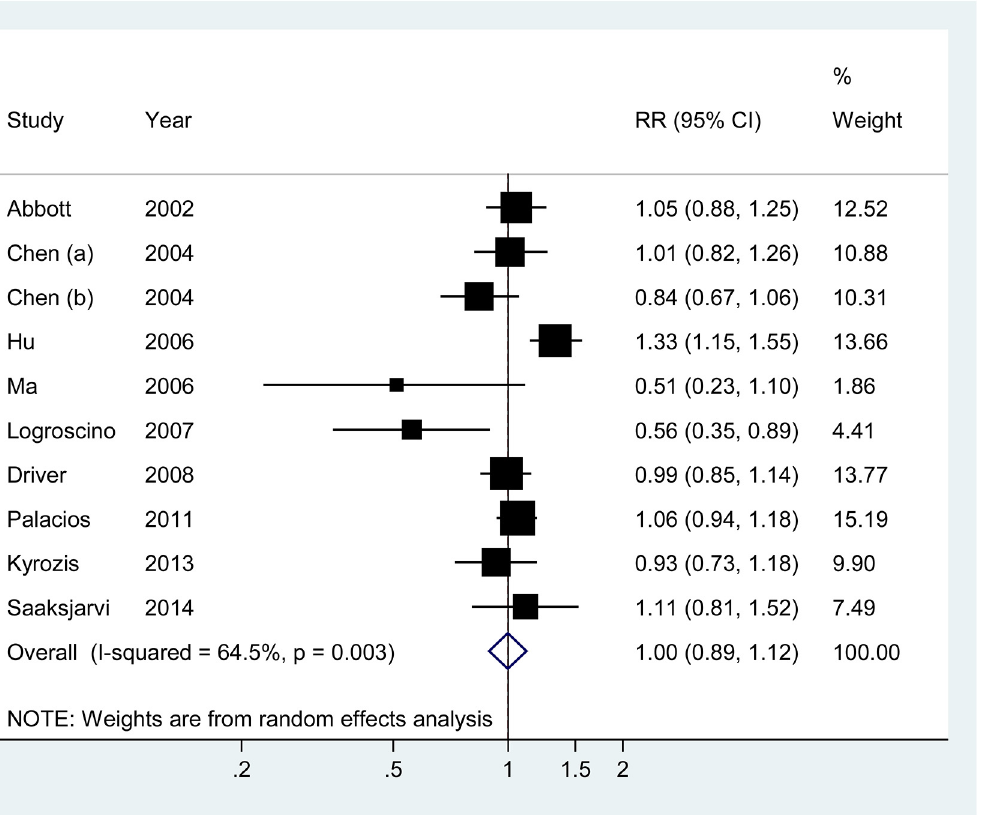
Fig 2. Relative risks and 95% confidence interval of Parkinson ’ s disease for an increment in body mass index of 5 kg/m 2 for individual studies and all studies